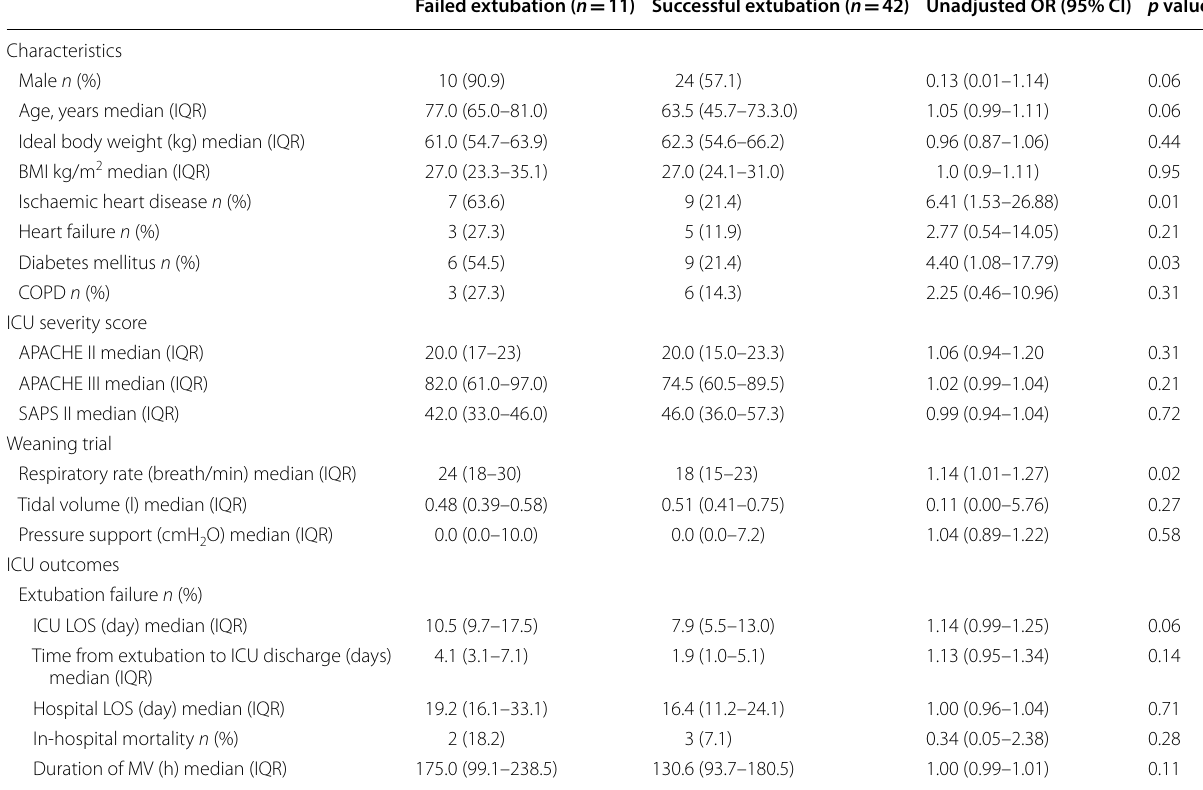
APACHE acute physiology age and chronic health evaluation, BMI body mass index, BNP B-type natriuretic peptide, COAD chronic obstructive airway disease, H LOS hospital length of stay, ICU LOS intensive care unit length of stay, SAPS simplified acute physiology score, IQR interquartile range